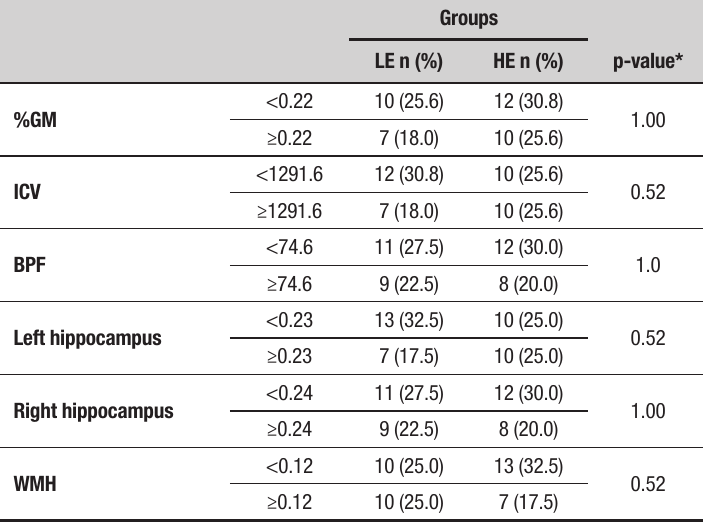
Table 3. Frequency tables and association test for proxies of brain reserve.